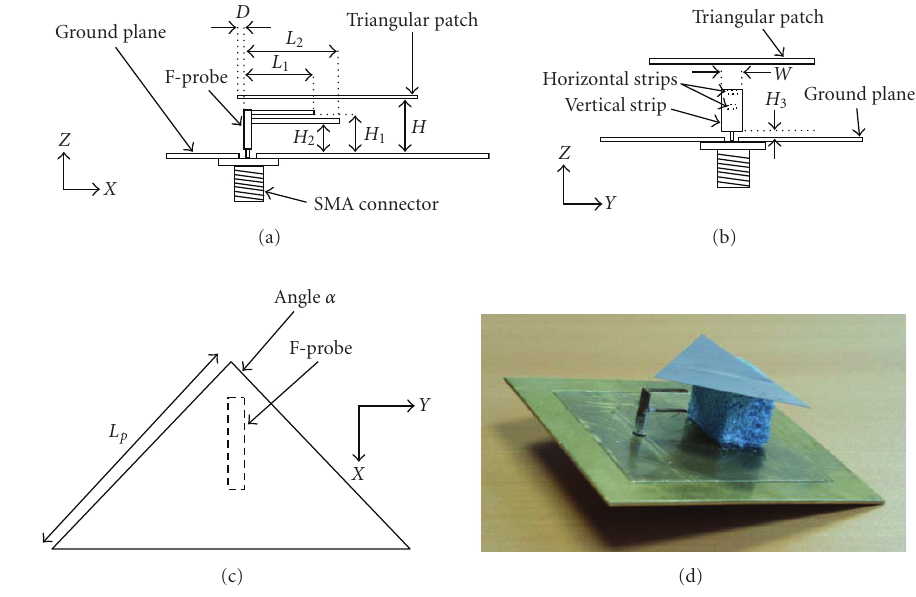
Figure 1: Geometry of the antenna and prototype.